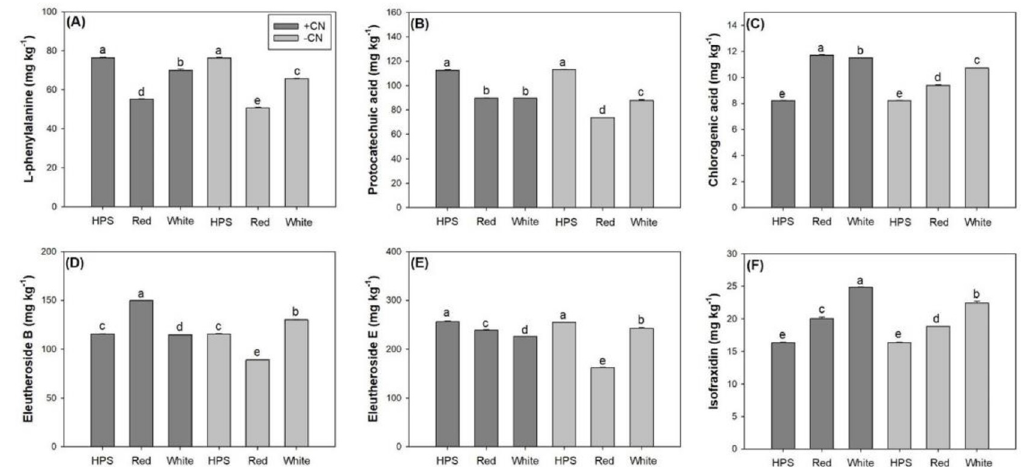
Fig 8. Contents of L-phenylalanine (A), protocatechuic acid (B), chlorogenic acid (C), eleutheroside-B (D), eleutheroside-E (E), and isofraxidin (F) in roots of Eleutherococcus senticosus seedlings subjected to combined spectra and chitosan nanoparticle addition (CN) treatments. + CN, with CN addition; -CN, without CN addition; HPS, high-pressure sodium spectrum; Red, red-light light-emitting diode (LED) spectrum; White, white-light LED spectrum. Error bars present standard errors and different letters are given over means with differences identified by Turkey test ( α <